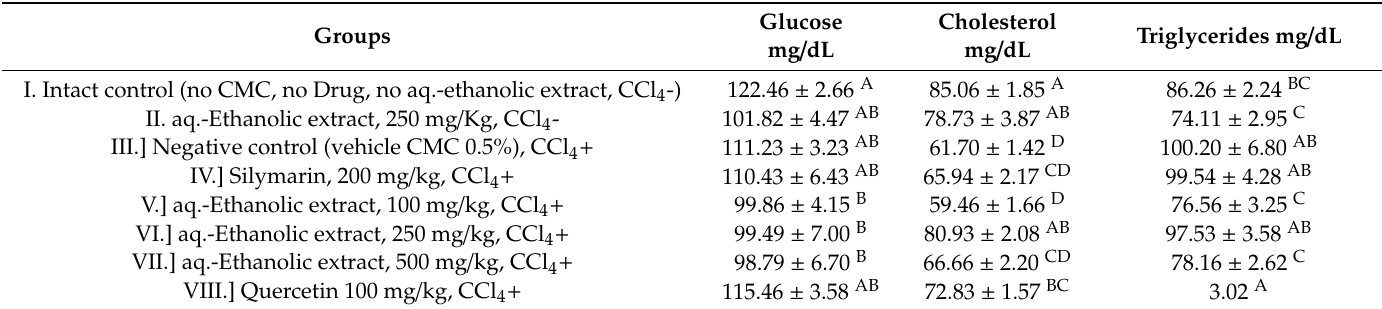
Table 4. E ff ect of aq.-ethanolic extract of Suaeda vermiculata on blood glucose, triglycerides, and cholesterol on carbon tetrachloride (CCl 4 )-induced liver toxicity in experimental rats